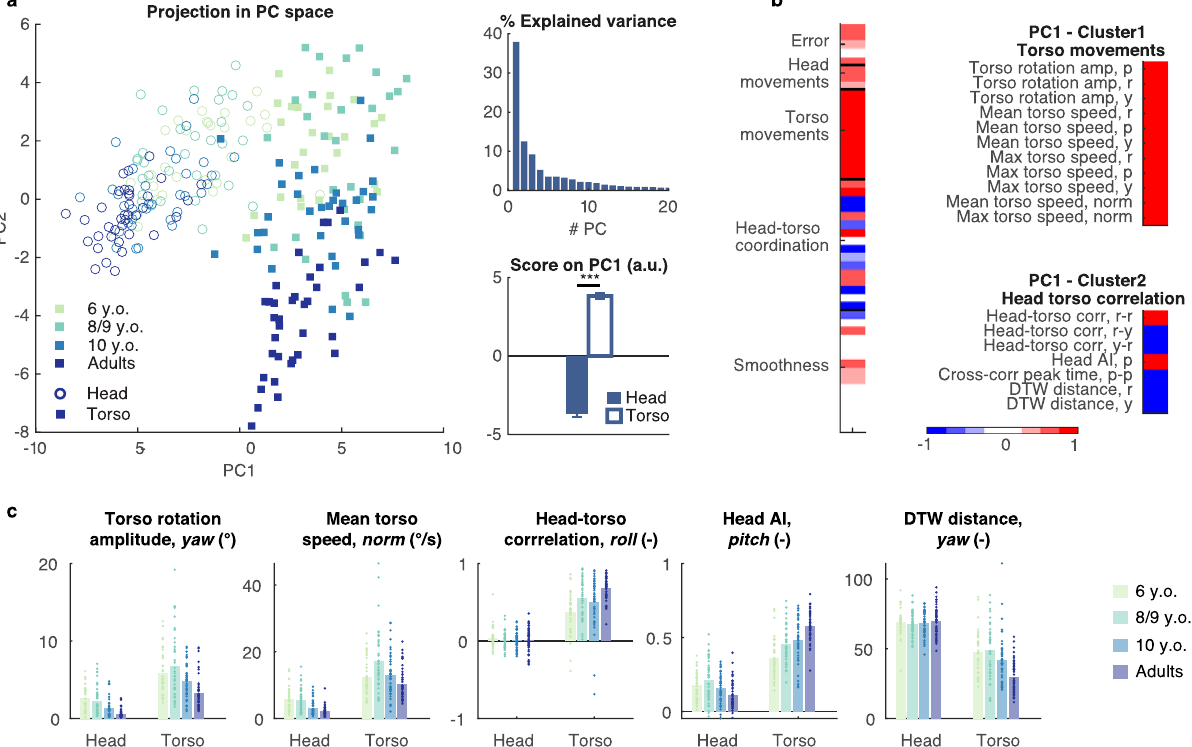
Figure 2. Segmental coordination and torso involvement differ between torso and head trials. ( a ) PCA applied to the data collected on all trials. The projection of the data in the space spanned by the first two PCs displays a control-based separation along the first component (left) representing 37% of the overall variance (top right). This division was confirmed by a t-test (bottom left, mean + SEM). ( b ) Normalized loadings of the descriptive variables on the first PC (left) and variables with absolute loadings higher than a threshold of 0.75 grouped into functional clusters. ( c ) Representative variables selected from the functional clusters with significant effect of Control. Dots represent the average value for each individual participant, bars the average across participants. N = 9 (6 y.o.), 12 (8–9 y.o.), 11 (10 y.o.), 13